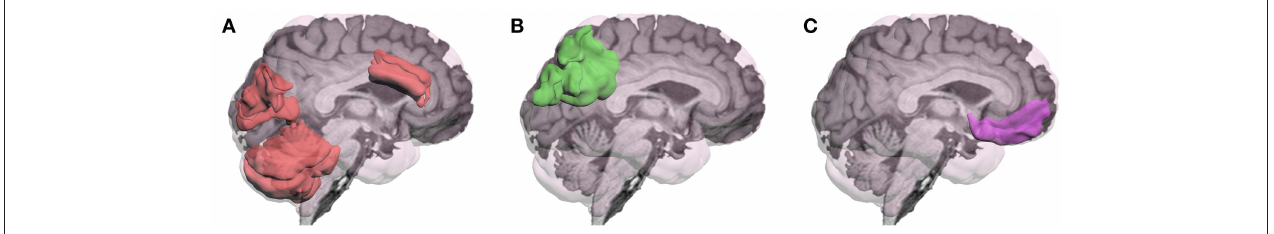
FIGURE 1 | Brain regions in which methylphenidate (MPH) has modulated activation during performance of cognitive tasks in patients with TBI have varied depending on the specific cognitive task: (A) Visual Working Memory: activation by an n-back task for photos of faces was modulated in anterior cingulate gyrus, cuneus, and cerebellum (16), and for letters in left cerebellum (18); (B) Visual Sustained Reaction Time (RT): MPH modulated deactivation of left posterior superior parietal region (17); (C) Response Inhibition: MPH modulated activation by the stop signal RT task in the right inferior frontal gyrus (19).